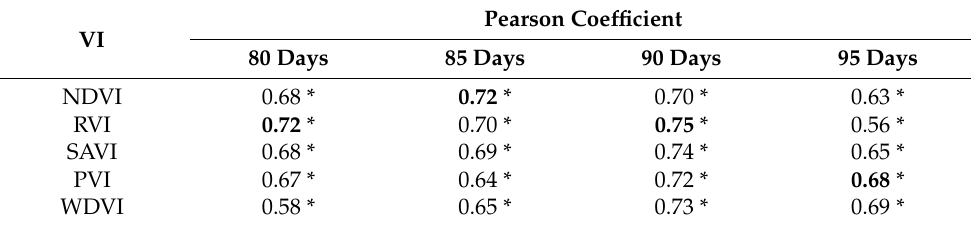
Table 7. The Pearson coefficient representing the relationships between the derived VIs and the yield of all